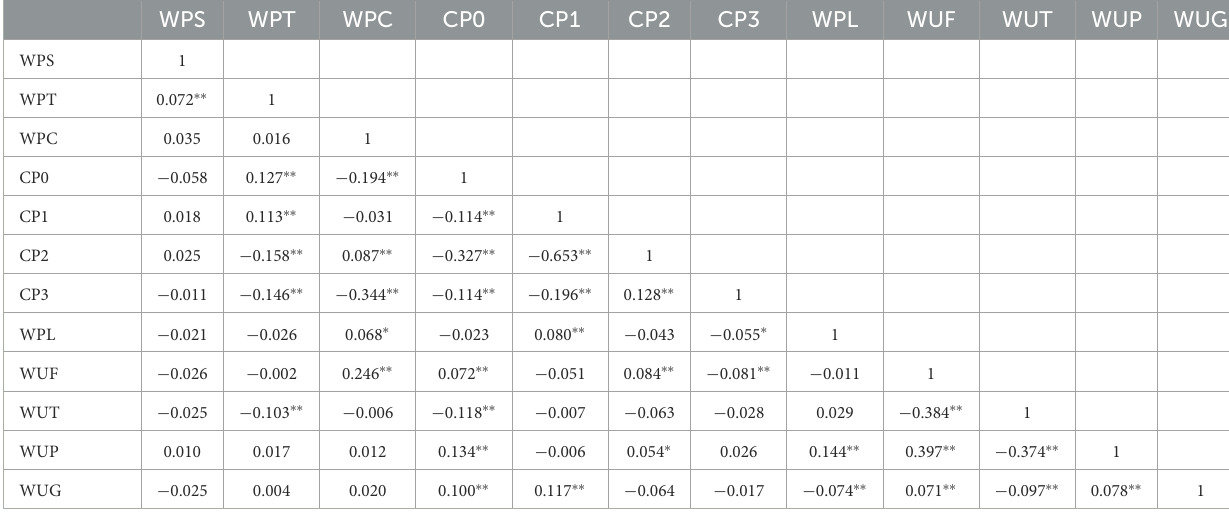
TABLE 5 Spearman correlation coefficient of the event “The Wuhan Red Cross”.